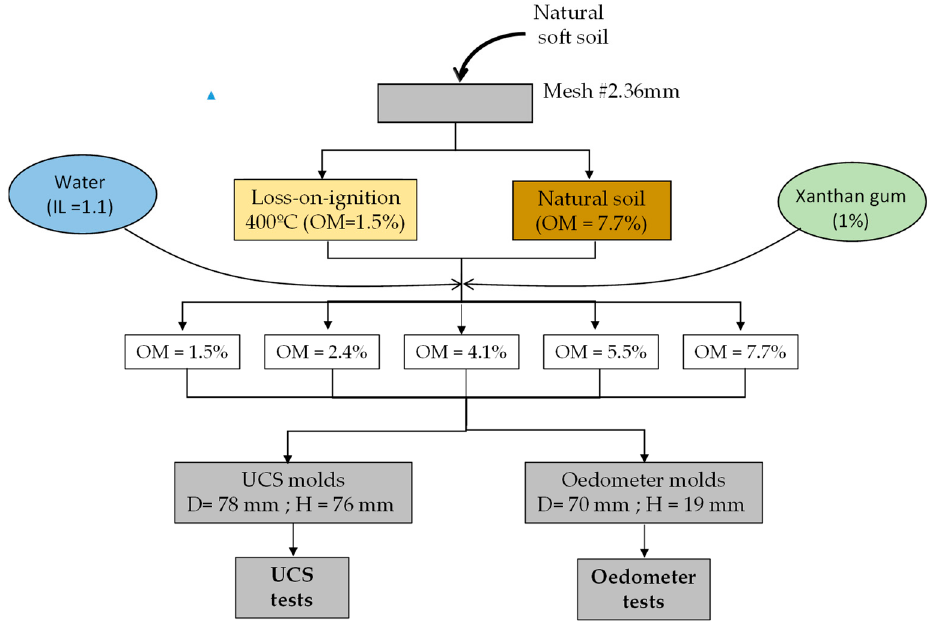
Figure 2. Flow chart of the specimen preparation.